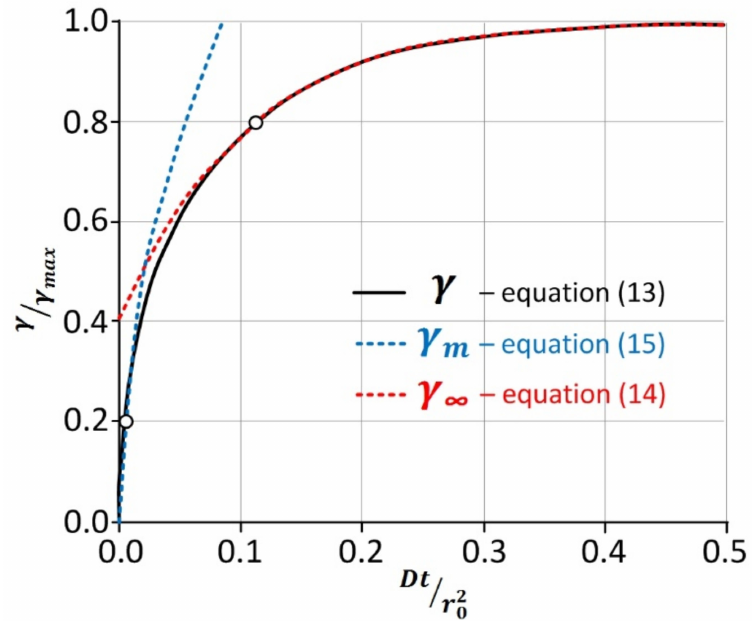
Figure 1. Comparison of approximate solutions (Equations (14) and (15)) of the linear diffusion equation with the exact solution (Equation